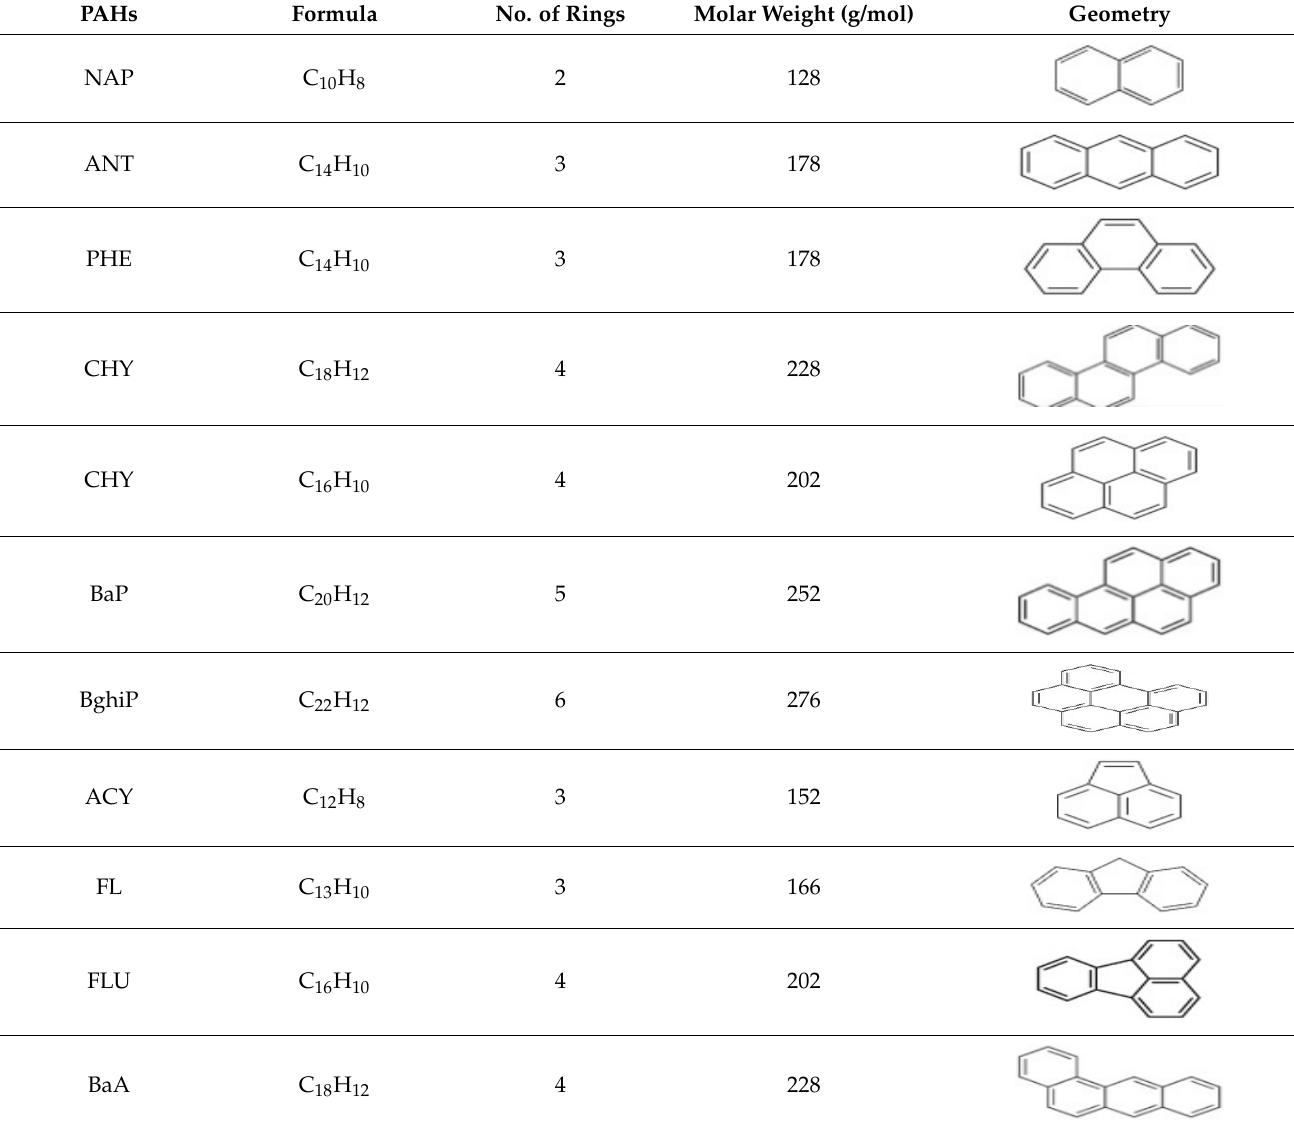
Table 2. Chemical and structural information of a few common PAHs compounds. Re-